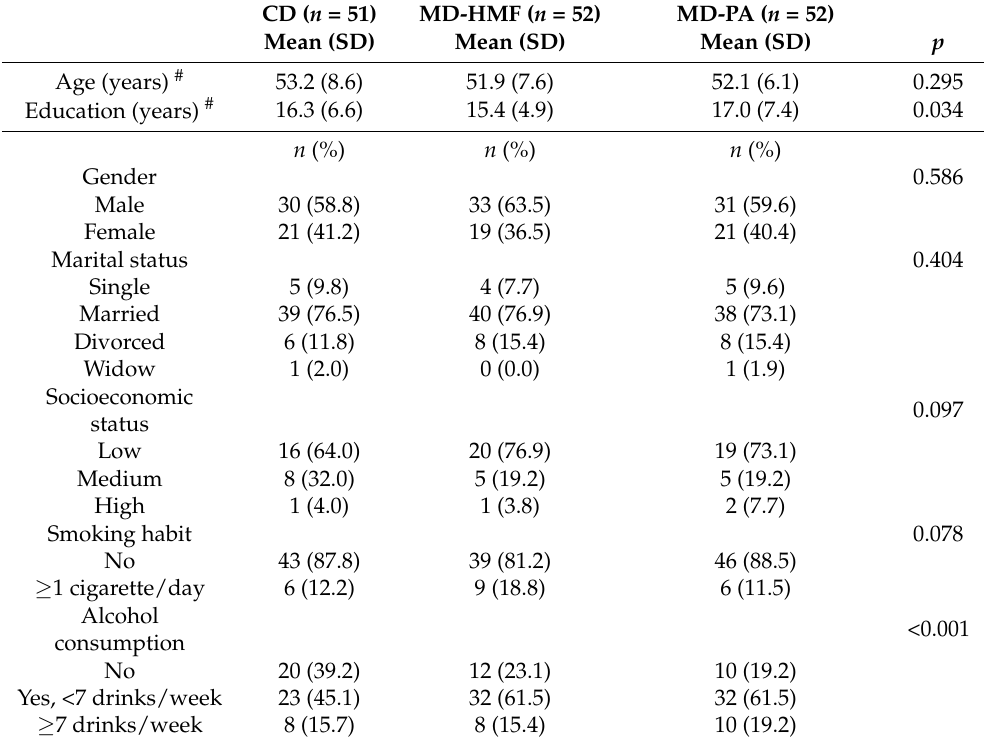
Table 1. Baseline sociodemographic characteristics of the studied